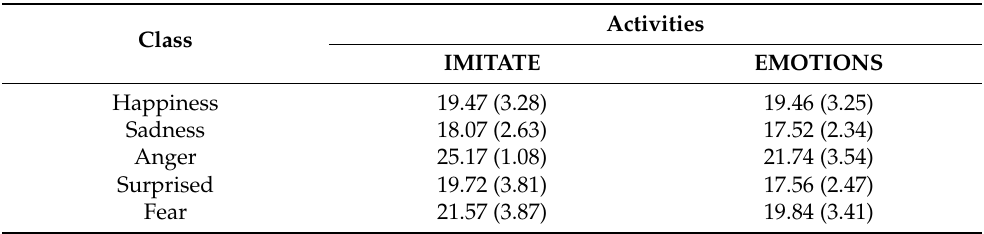
Table 6. Children’s mean response time in seconds per facial expression (SD) in the IMITATE and EMOTIONS